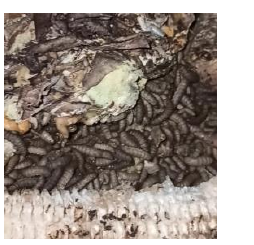
Figure 6: Few larvae of